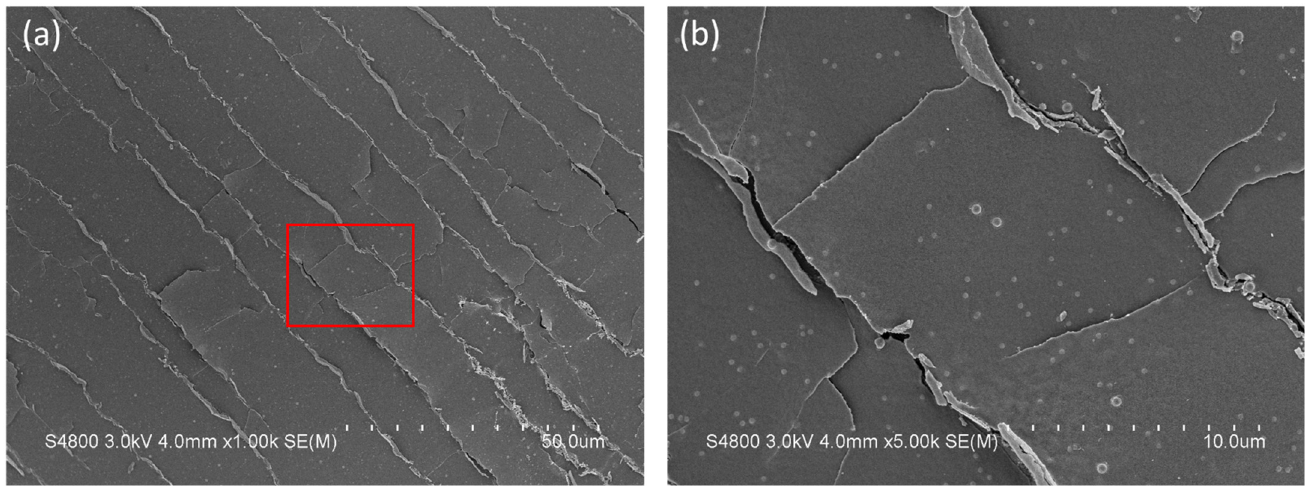
Figure 10. SEM images showing the compressive-stress-caused failure of OMO samples after cyclic bending: ( a ) low-magnification image of the 15 d aged OMO sample; ( b ) zoom-in of the red rectangular area in ( a ).